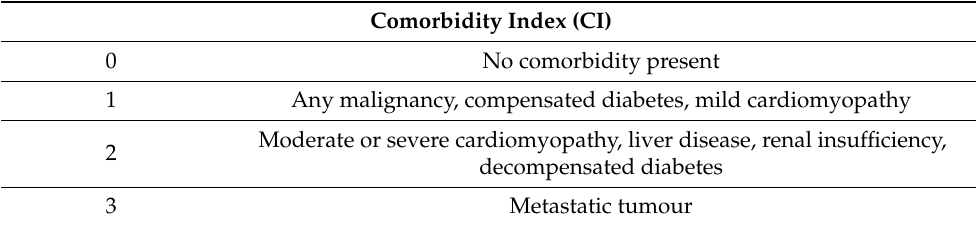
Table 1. Charlson Comorbidity Index modified classification.